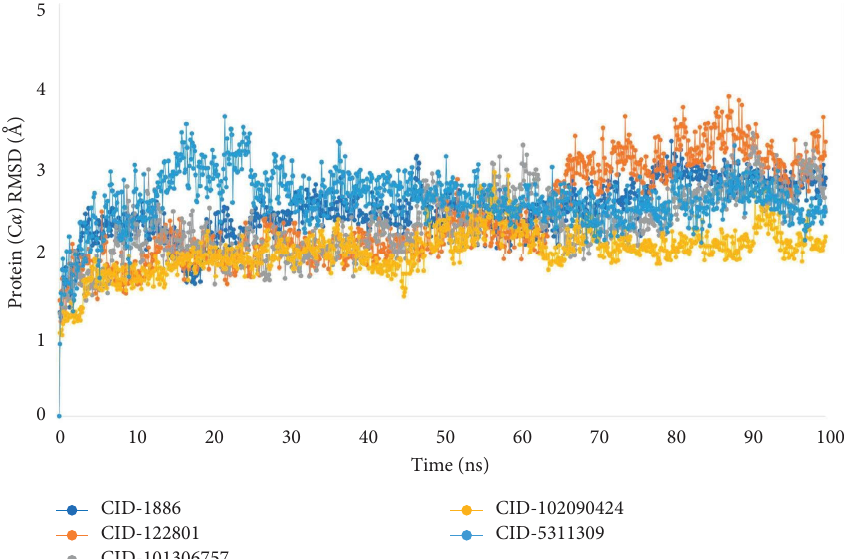
Figure 2: Te RMSD values for the 4 ligand molecules and the nateglinide control for the 1i44 protein model. Te selected compounds with the CIDs 1886, 122801, 101306757, 102090424, and 5311309 in relationship with the protein were represented by the hues dark blue, orange, gray, yellow, and light blue, respectively, while the control medicine had the CIDs 5311309 in association with the protein.